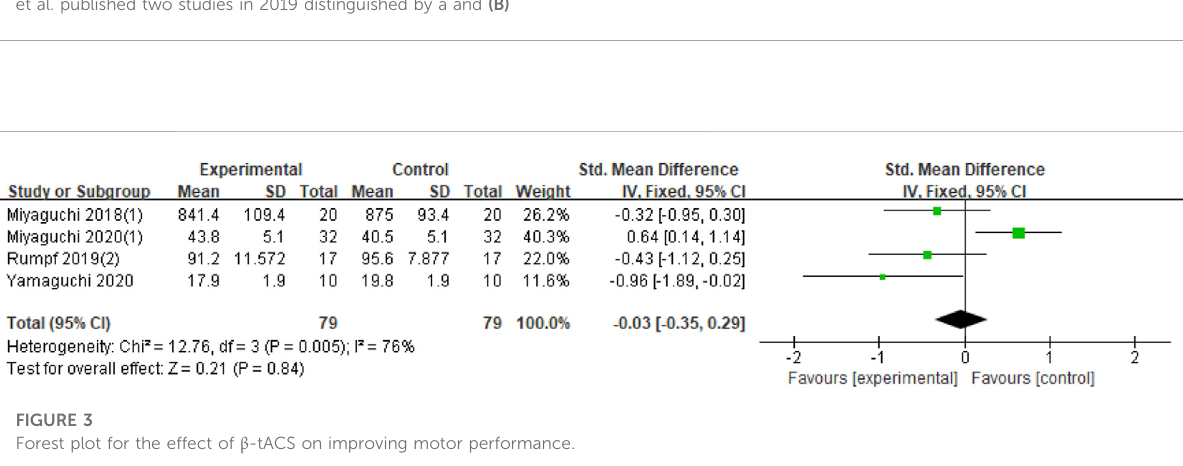
FIGURE 2 Forest plot for the effect of tACS on improving motor performance. Notes: Giustiniani (1) (2) (3) (4) (5)-The fi ve outcome measures in Giustiniani ’ s study were SCPT, SBOMBT, SJ, CMJ, CMJ-AS; Miyaguchi 2018 (1) (2)- The 20 Hz and 70 Hzstimuli inthisstudy, respectively; Miyaguchi 2020 (1) (1)- The 20 Hz and 80 Hz stimuli in this study, respectively; Rumpf (1) (2)- The 10 Hz and 20 Hz stimuli in this study, respectively; Miyaguchi et al. published two studies in 2019 distinguished by a and (B)